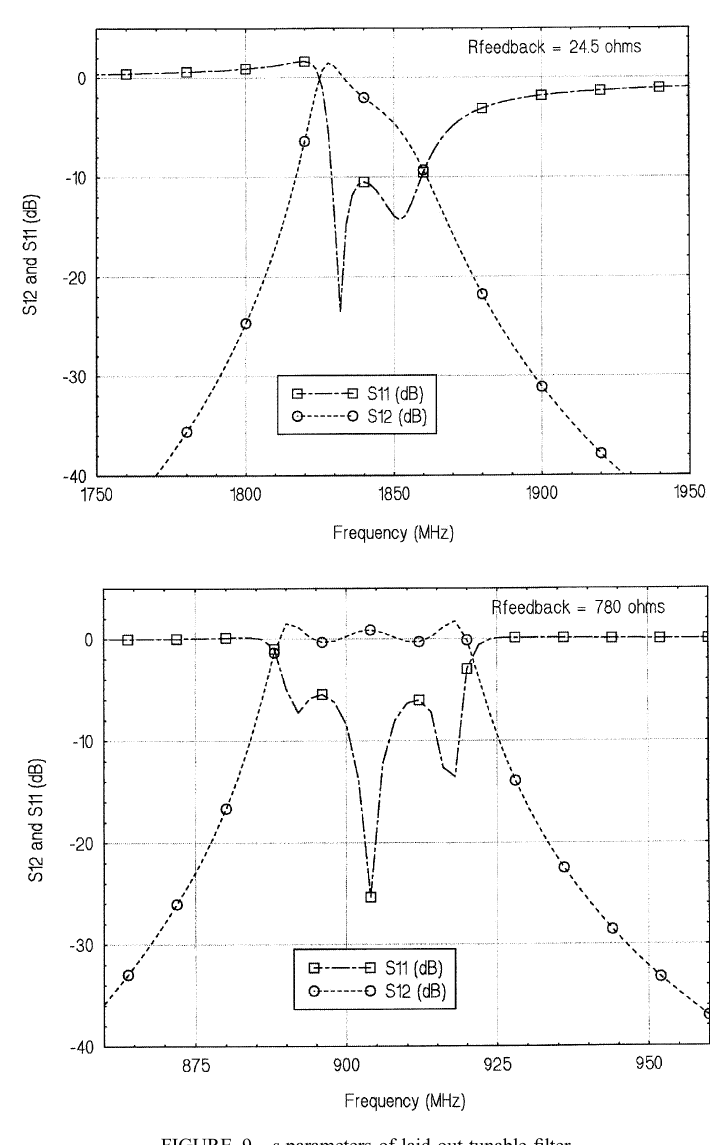
FIGURE 9 s -parameters of laid-out tunable